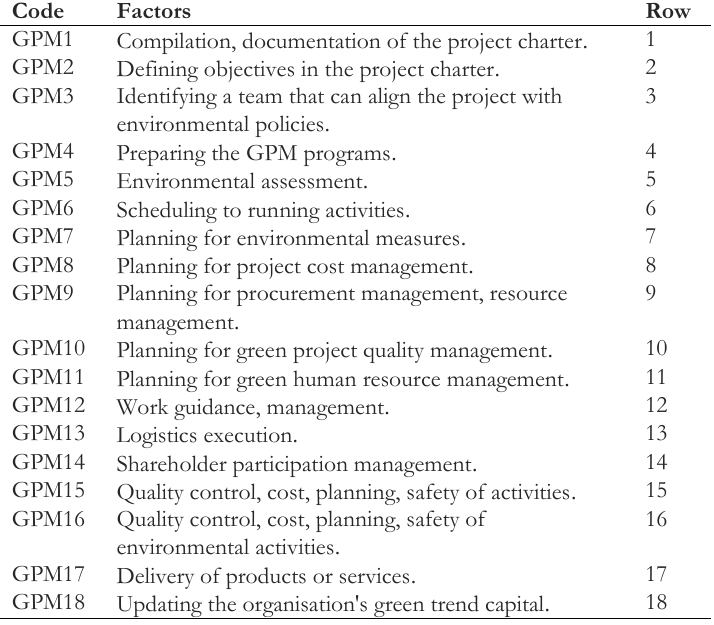
Table 6. Coding of alternatives